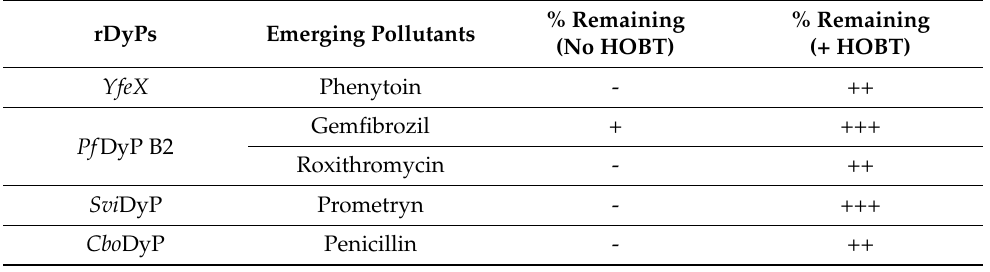
Table 3. Selected emerging pollutants that showed an enhanced degradation after treatment by specific rDyPs in the presence of the redox mediator,